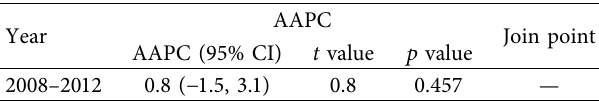
Table 7: AAPC of age-standardized mortality of female breast cancer in urban Shenyang in 2008–2017.